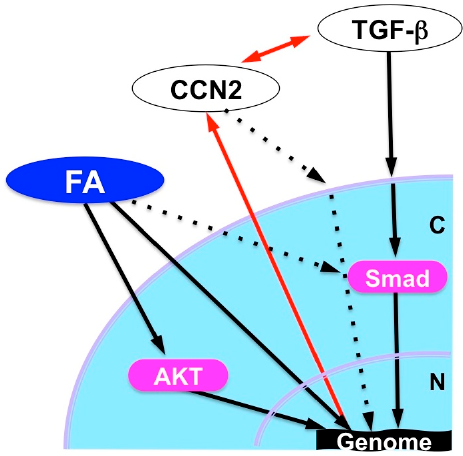
Figure 8. Possible cartilage regeneration mechanism by FA in collaboration with TGF- β . N, Nucleus; C, cytoplasm; FA, fluocinolone acetonide.